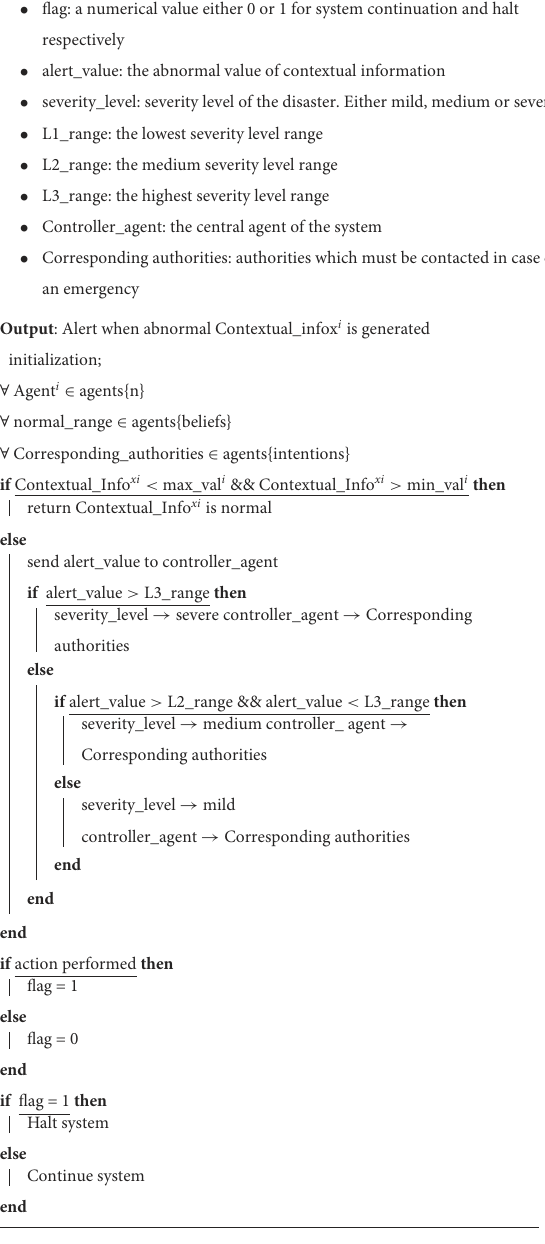
Algorithm 1: Reasoning algorithm.